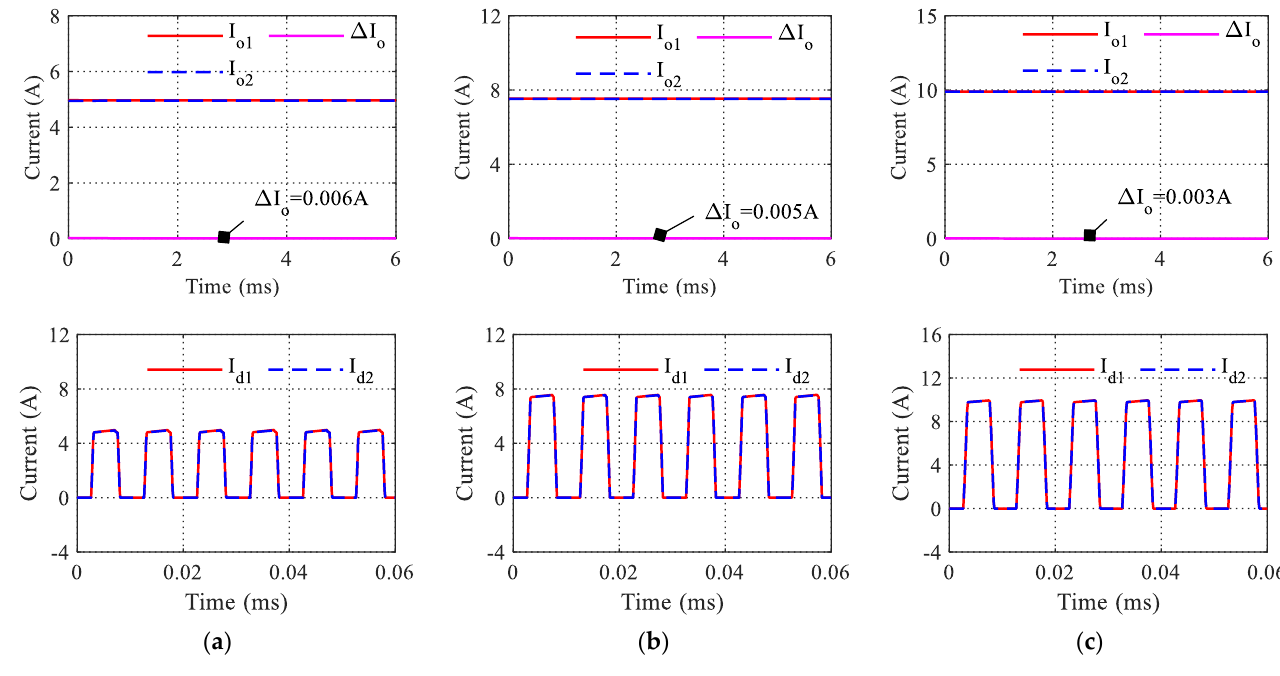
I and I in different P when b = 1.2: ( a ) o d o P = 800 W. R = 2  , o o